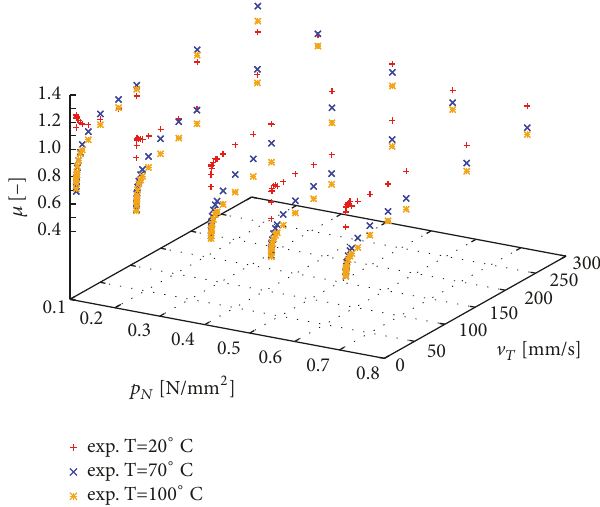
Figure 1:Frictioncoefficientatvariouscontactpressures 𝑝 𝑁 , sliding velocities V 𝑇 , and temperatures 𝑇